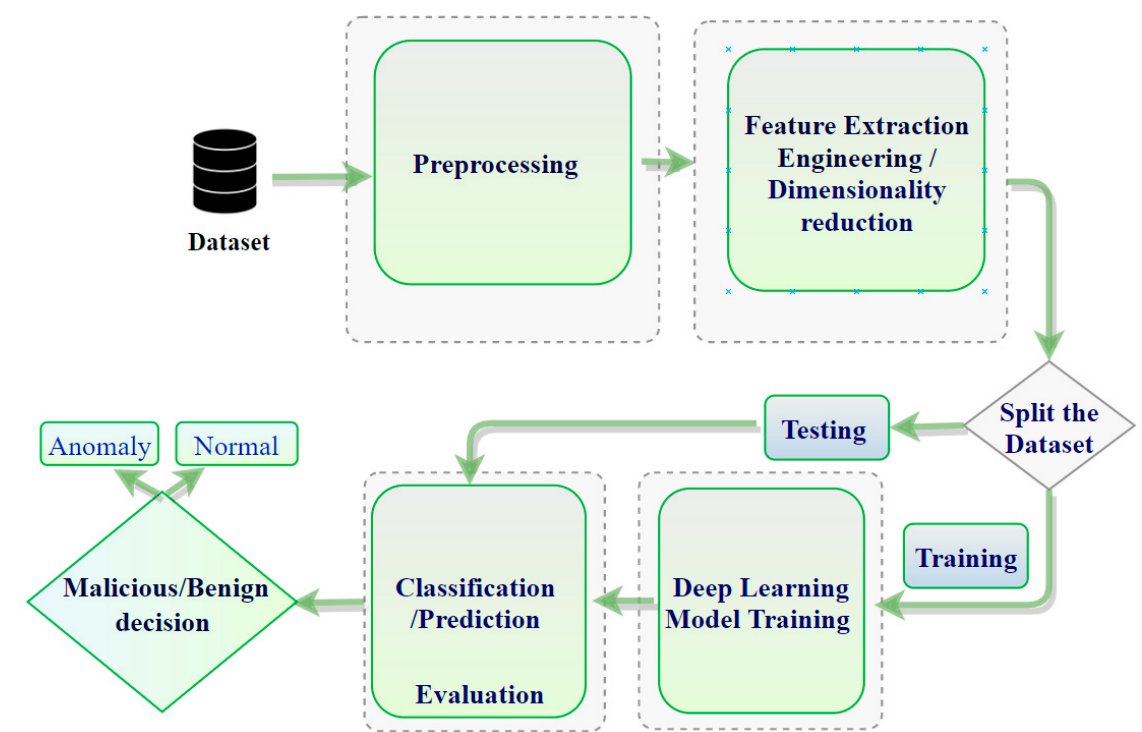
Figure 4. Diagram of the framework of IDS based on deep learning.